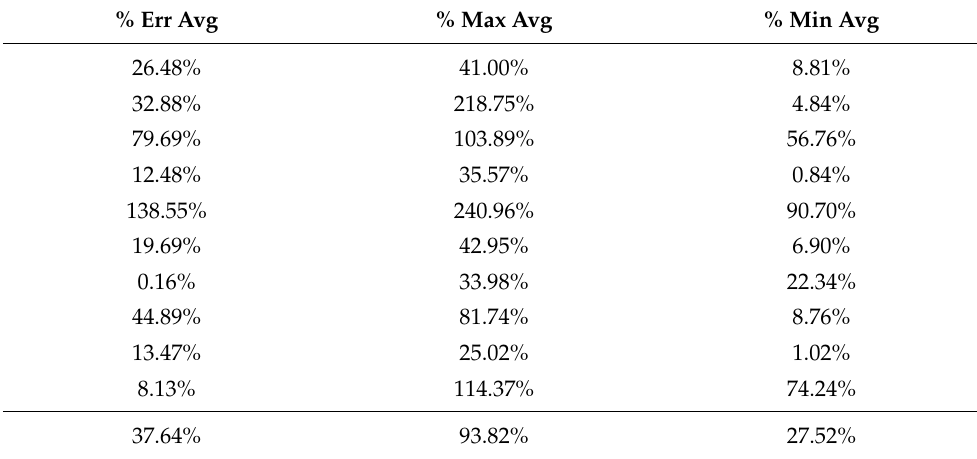
Table A168. Set 3, trials 1–10 data (average actual PR